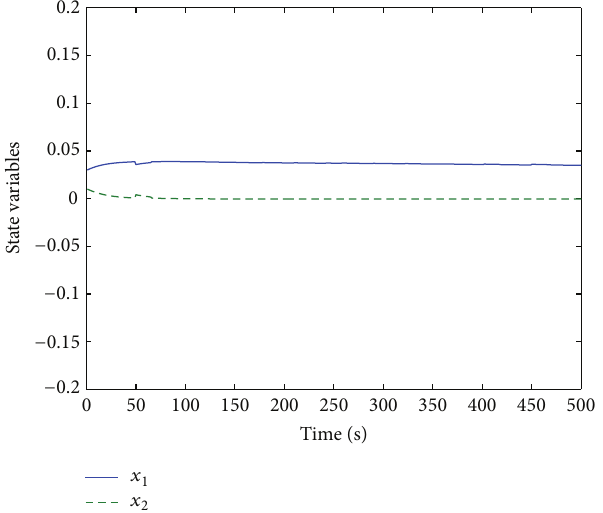
Figure 6: The state responses of the system (22).